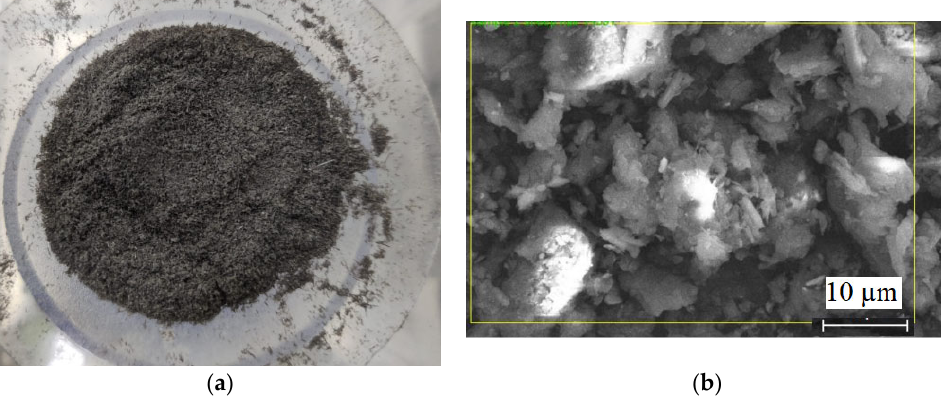
Figure 8. ( a ) Hair micropowder used in the prototype. ( b ) SEM image of the hair micropowder. Table 1. Results for EDX analysis.